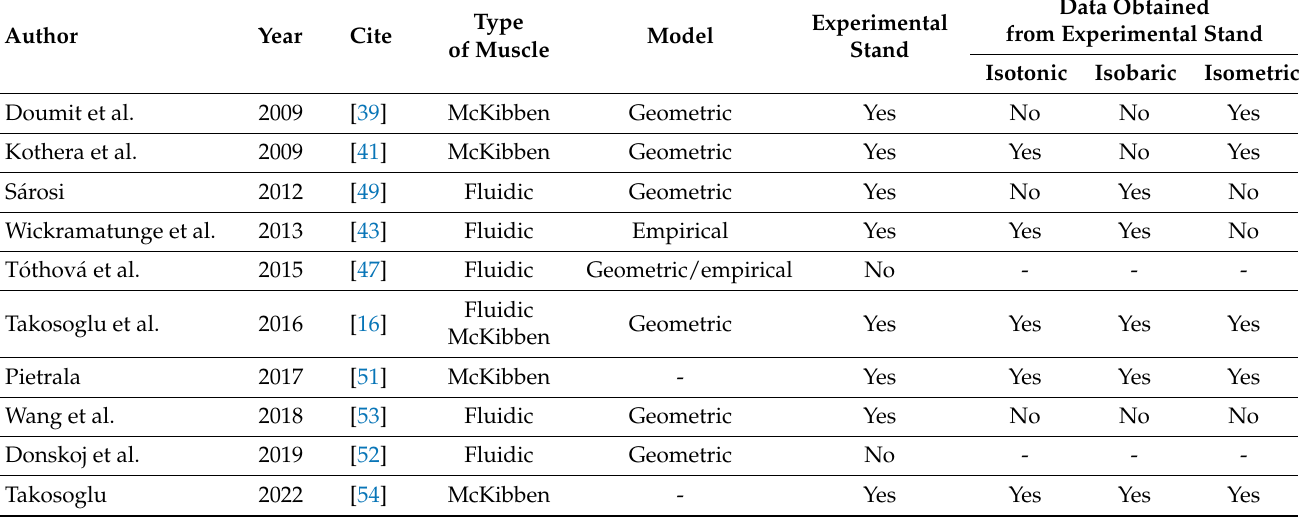
Table 2. Overview of the related